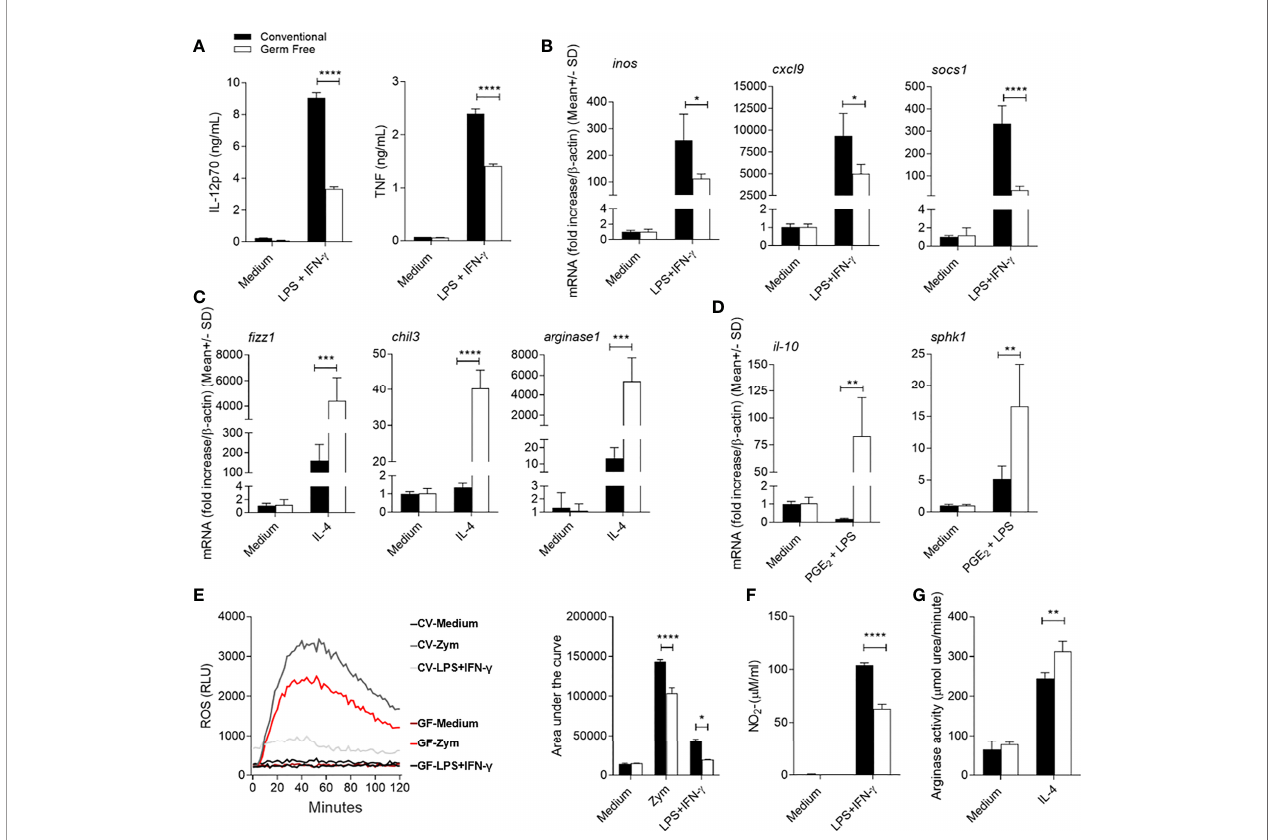
FIGURE 6 | In fl uence of host microbiota on BMDM activation pro fi le and response. (A) IL-12p70 and TNF in IL-12p70 and TNF assayed by ELISA in BMDM culture supernatant 48h and 24h after stimulation with LPS+IFN- g , respectively. (B) Expression of inos , cxcl9 and socs1 mRNA in BMDM by real-time PCR after stimulation with LPS+IFN- g for 24h. (C) Expression of fi zz1 , chil3 and arg1 mRNA in BMDM by real-time PCR after stimulation with IL-4 for 24h. (D) Expression of Il10 and s phk1 mRNA in BMDM by real-time PCR after stimulation with PGE 2 +LPS for 24h. (E) Production of reactive oxygen species (ROS) by BMDM unstimulated or stimulated with Zymosan (Zym); or with LPS + IFN- g for 2h. (F) Nitrite production in the supernatant of BMDM by the Griess method, after 48h of stimulation with LPS + IFN- g . (G) Measurement of arginase activity in BMDM after 48h of stimulation with IL-4. *, **, ***, **** indicates statistical difference between the two groups at the same time point using two-way ANOVA and post-Bonferroni test (p < 0.05; p < 0.01; p < 0.001; p < 0.0001). Results are representative of three independent